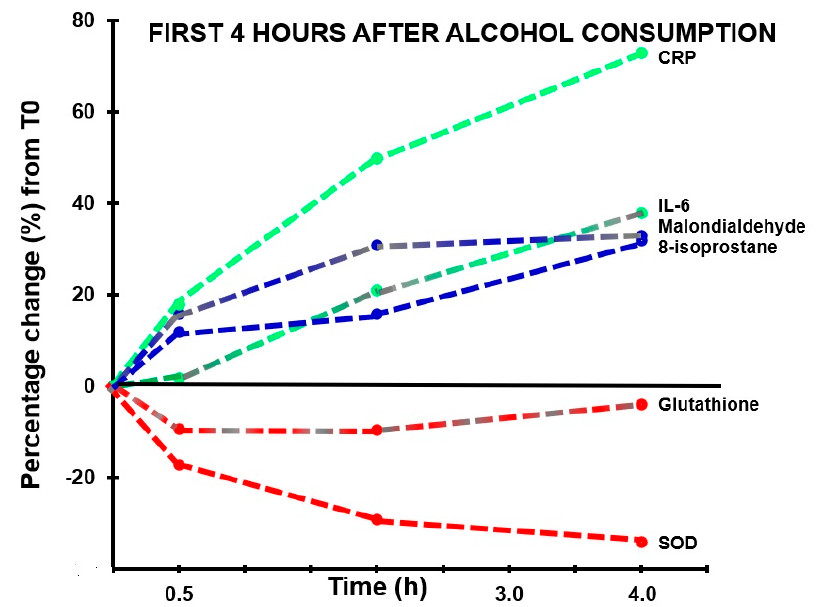
Figure 2. Markers of oxidative stress and inflammatory responses in the first four hours after alcohol consumption. Percentage changes between assessments made in the first 4 h after alcohol consumption relative to T0 (the assessment made before alcohol consumption) are shown. Abbreviations: CRP = C-reactive protein, IL-6 = interleukin-6, SOD = superoxide dismutase.